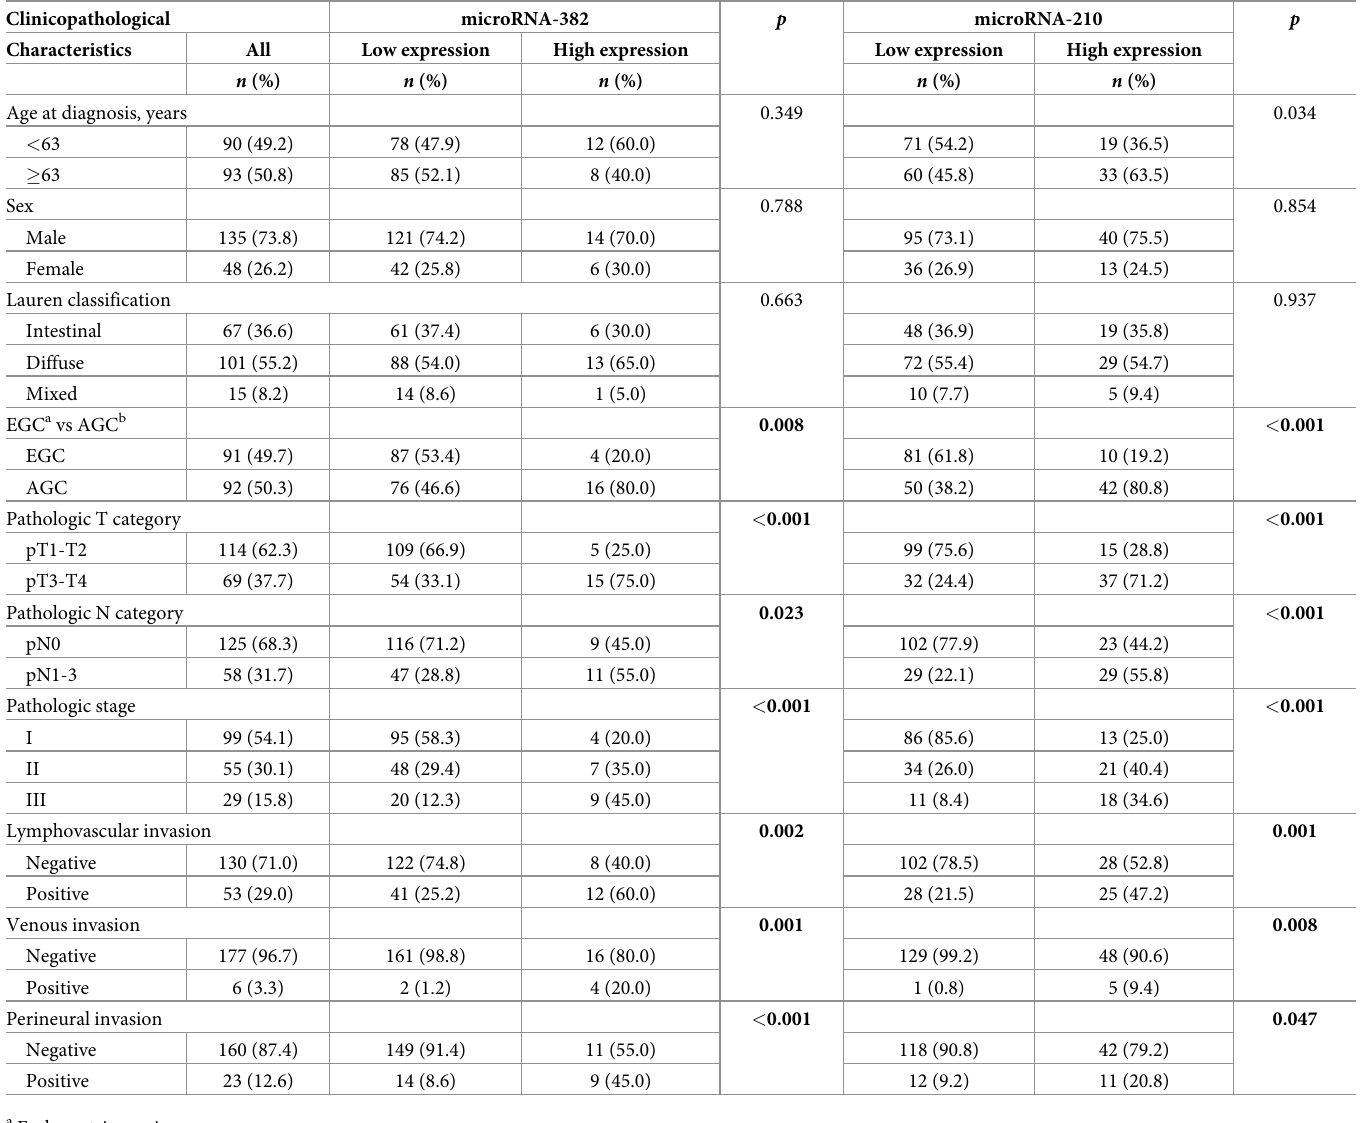
Table 1. Relationship between clinicopathologic characteristics of tumor and expression levels of miR-382 and miR-210 in gastric adenocarcinoma.